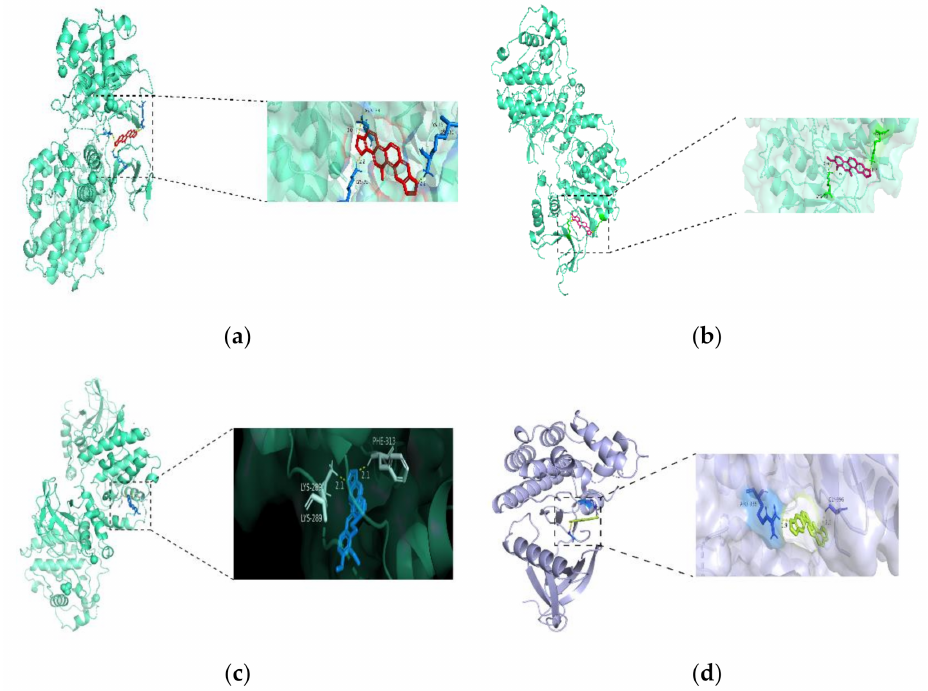
Figure 10. Molecular docking results: ( a ) SAN and MAPK3; ( b ) CHE and MAPK3; ( c ) ALL and MAPK3; ( d ) PRO and